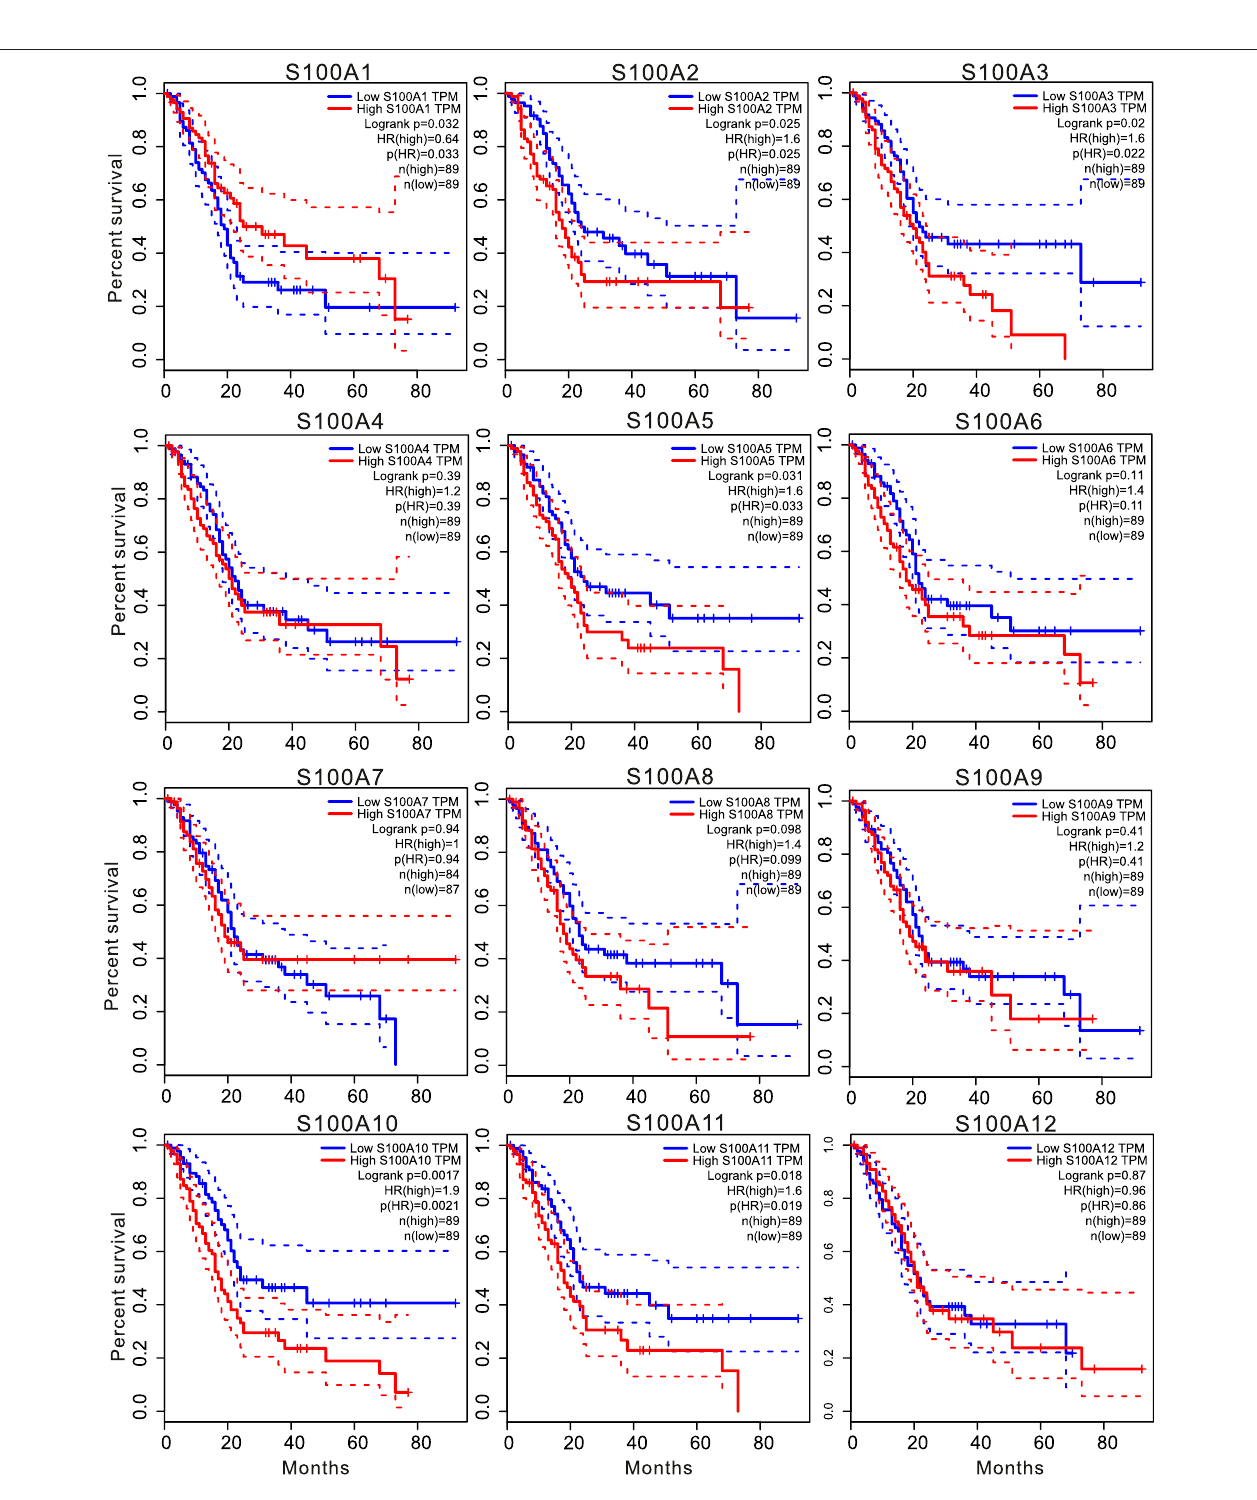
FIGURE 6 | Kaplan-Meier survival analysis showed that higher mRNA expression of S100A2/A3/A5/A10/A11/A14/A16 was signi fi cantly associated with shorter survival time, while higher expression of S100A1/B/Z was associated with longer survival time (GEPIA,n (cid:1) 178). The p- value was less than 0.05.